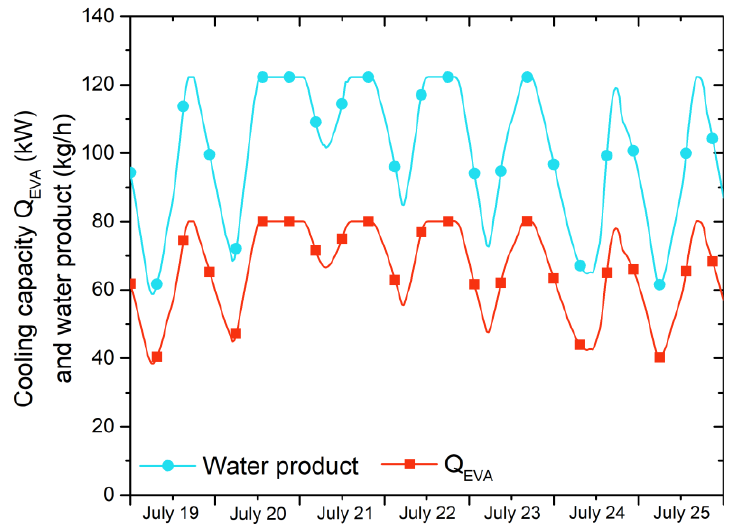
Figure 9. Behavior of cooling capacity and water product during the critical summer week.